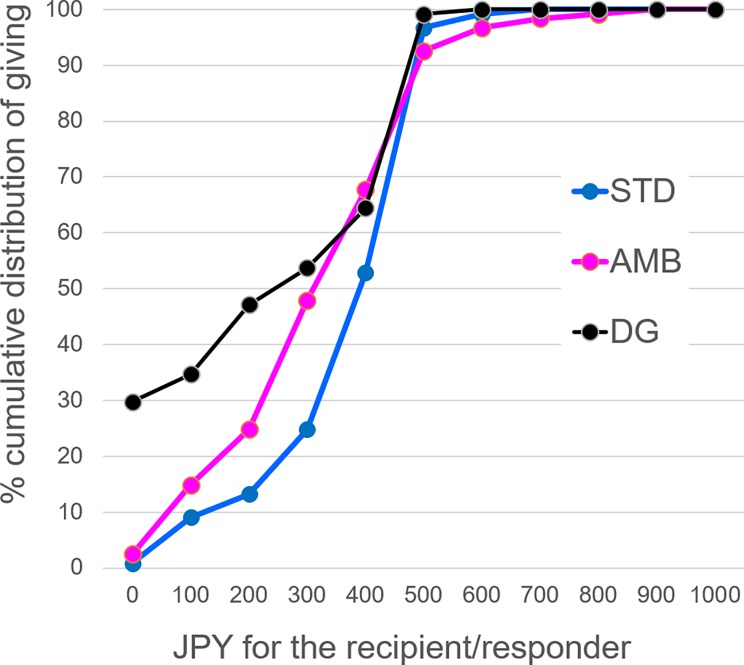
Cumulative distribution of giving in the three games (DG, UGSTD, and UGAMB).The vertical axis represents the percentage of responders whose (proposed) giving to the recipient (responder) is the JPY shown on the horizontal axis or less.